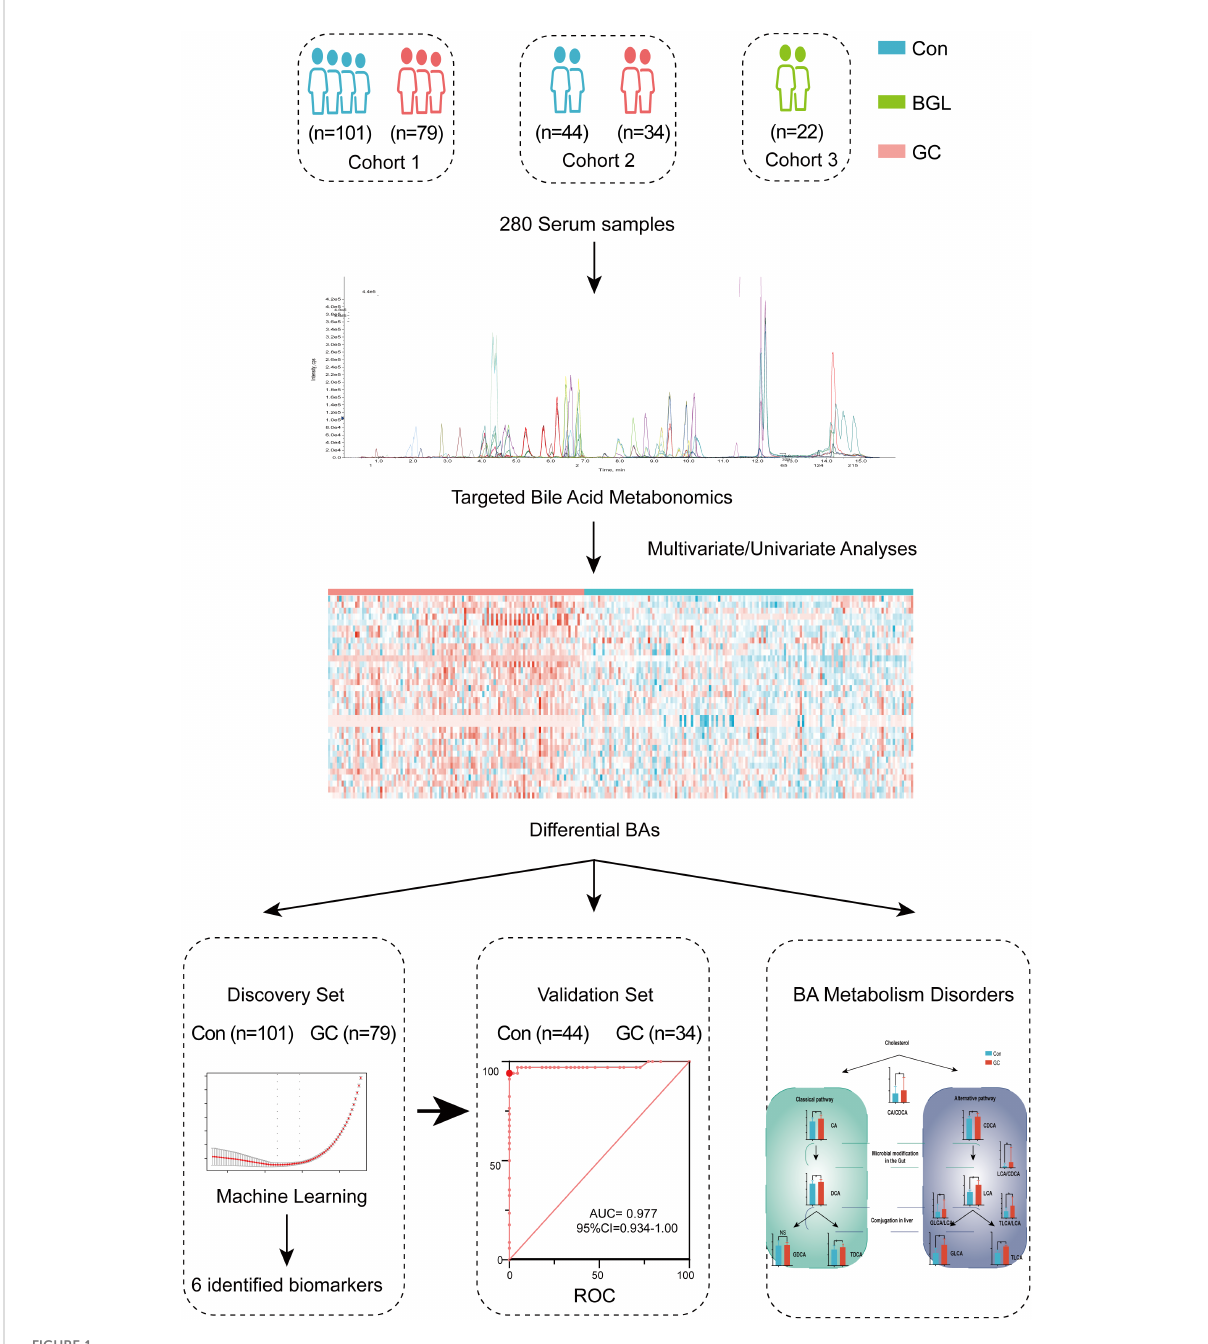
FIGURE 1 Global design and schematic representation of the